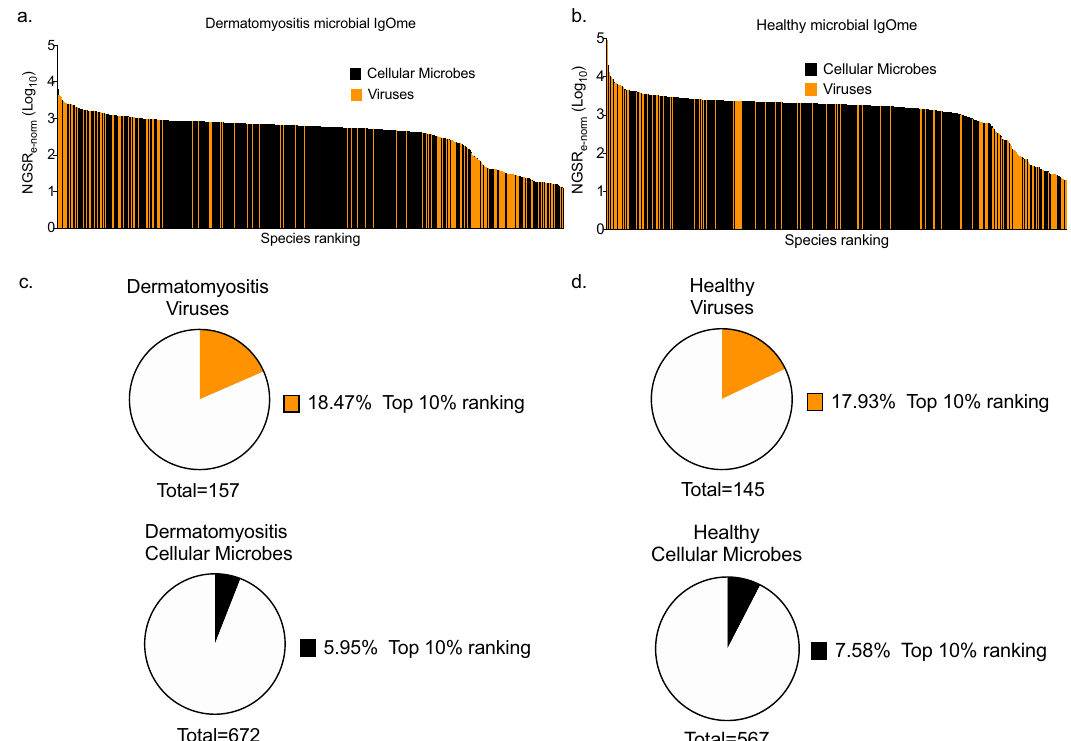
Fig. 3 Ranking of identi fi ed microbial species based on the number of NGS reads and a number of epitopes. Microbial species targeted by the identi fi ed antibodies were grouped in cellular microbes (Bacteria, Eukaryota and Archaea) and viruses and ranked based on the NGSR e-norm . The distribution of members of the two groups can be seen in a dermatomyositis, and b healthy controls; viruses were superimposed over cellular microbes. The pie charts depict the proportion of each microbial group that is represented in the top 10% of ranked species in c dermatomyositis and d healthy controls. Orange: viruses, Black: cellular